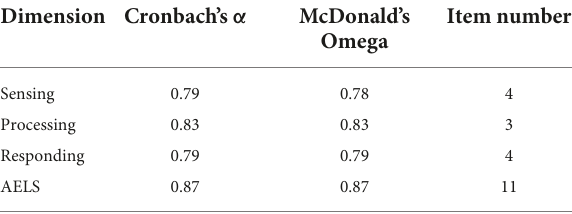
TABLE 2 Internal consistency reliability of the